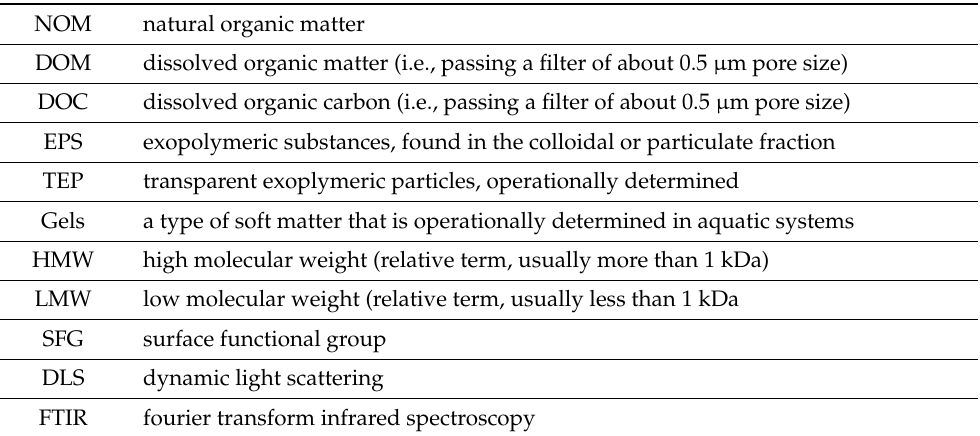
Table 1. Terminology used in this